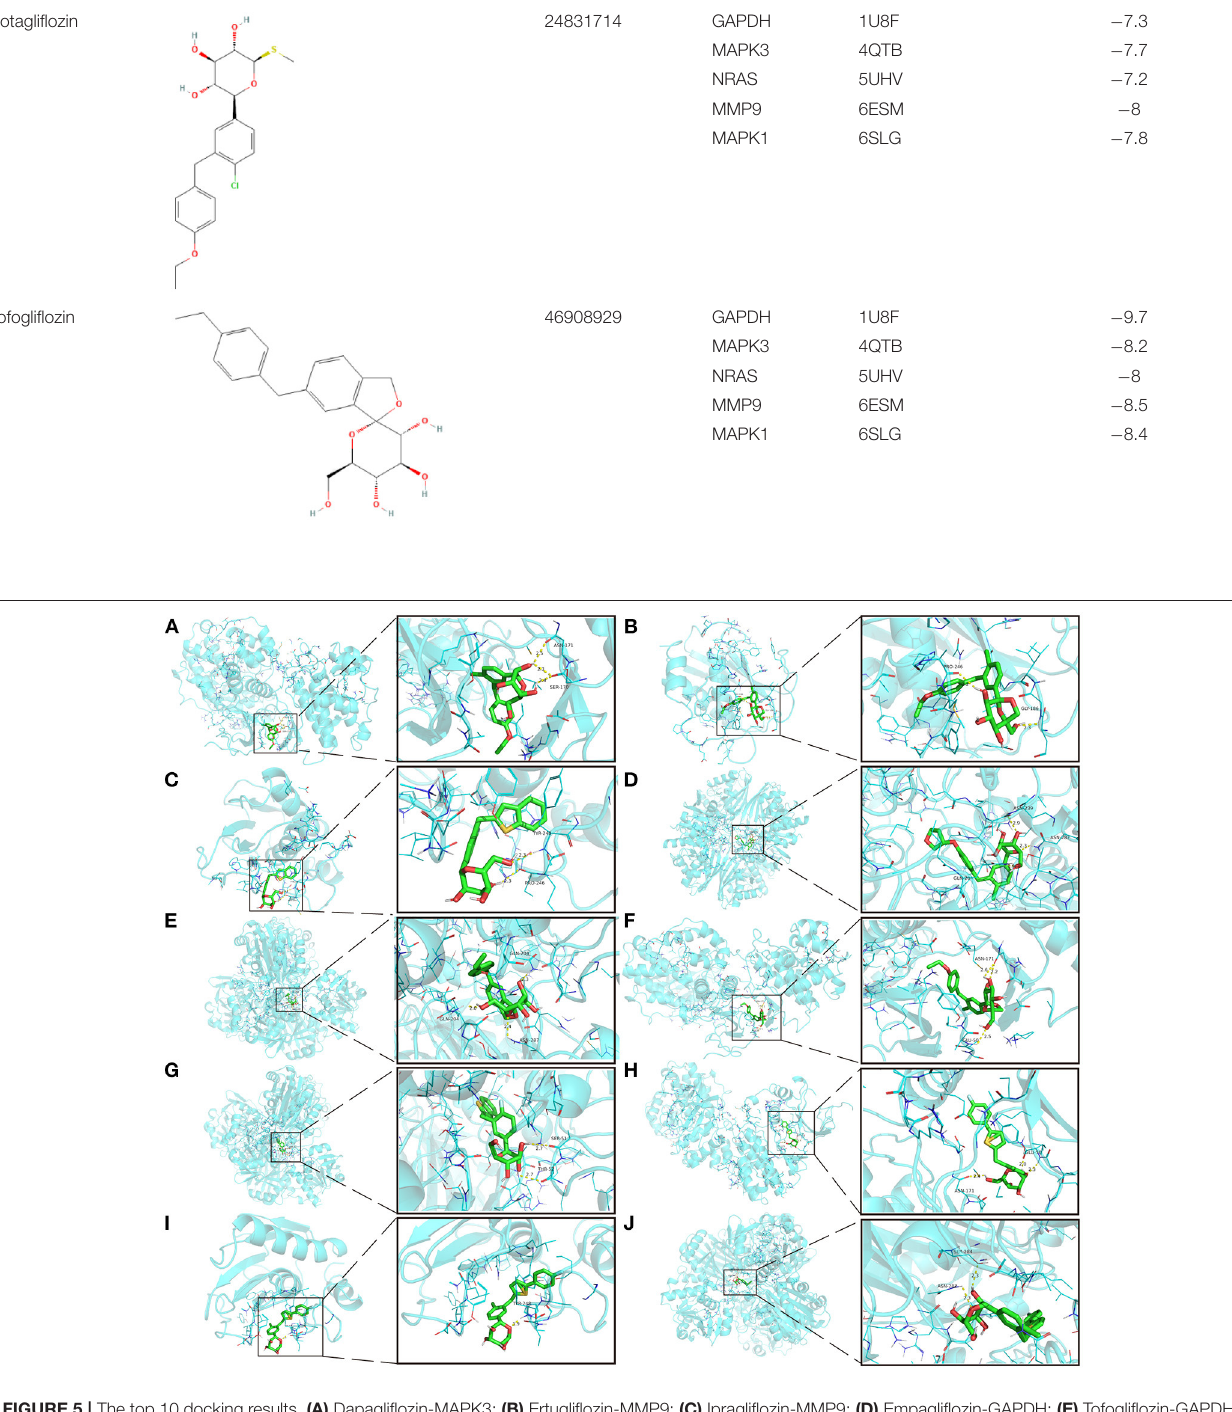
Frontiers in Cardiovascular Medicine |